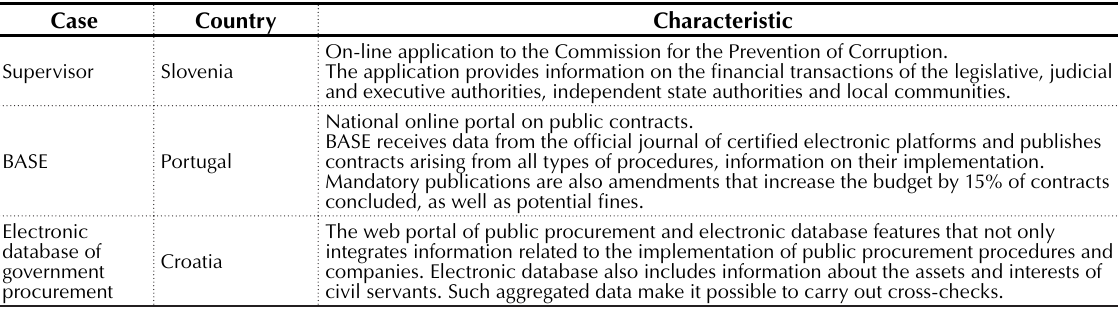
Table 1. Examples of implemented initiatives for applying IT in the prevention of corruption Source: Compiled by the authors based on Buehn and Schneider (2009).